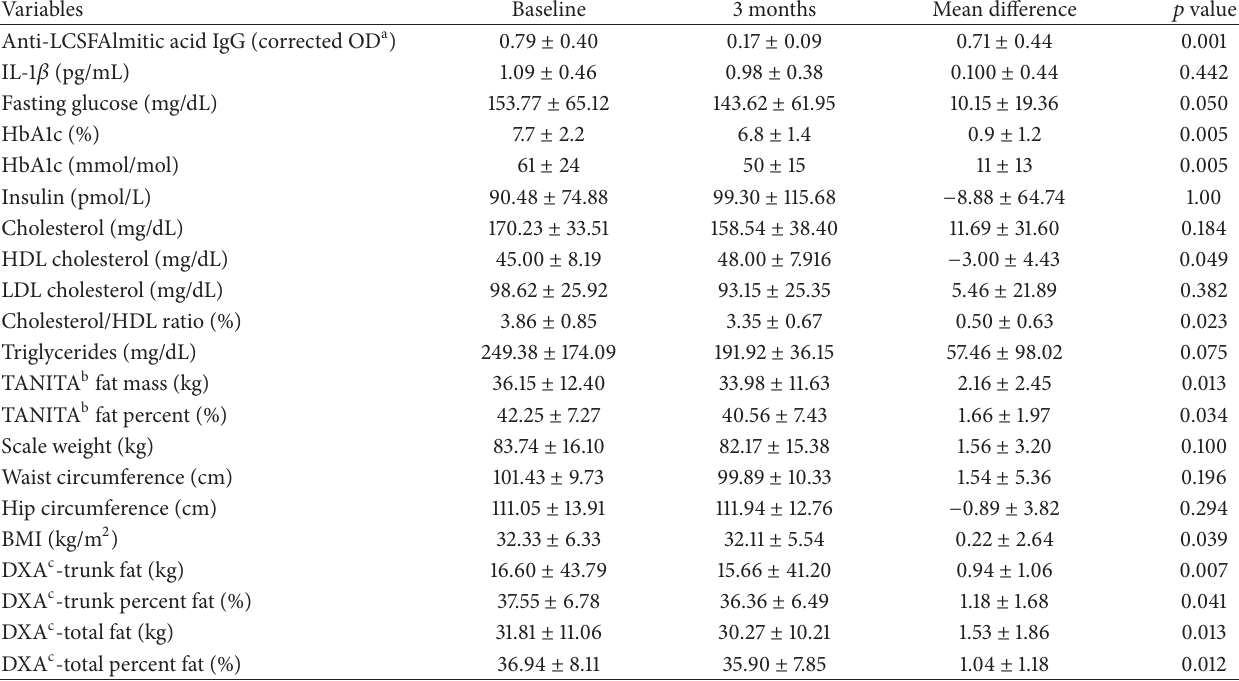
Table 4: Study participant clinical characteristics with complete datasets at baseline and 3 months, 𝑛 = 13 . Values are presented as the mean ± SD.